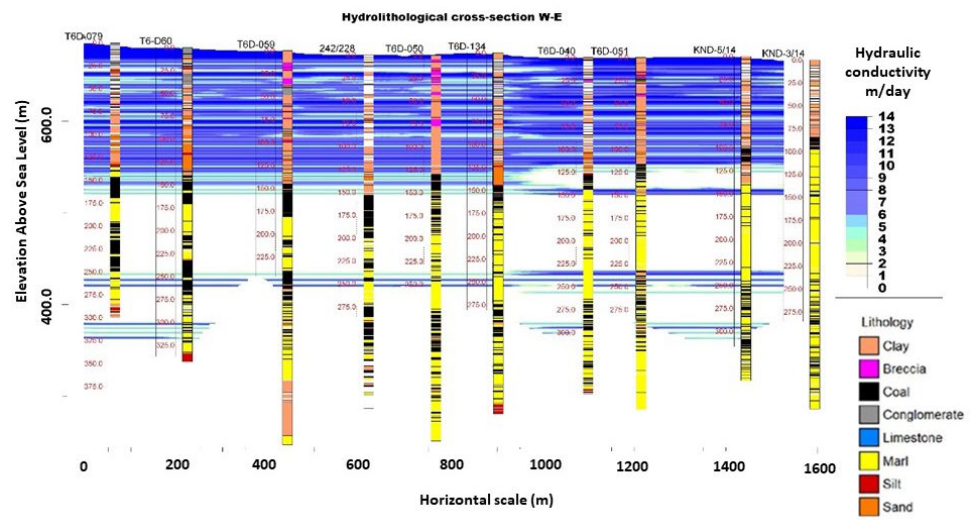
Figure 15. W-E Hydrolithological cross-section on selected boreholes with Vertical Exaggeration x2. Vertical axis represent elevation above sea level (a.s.l) values.